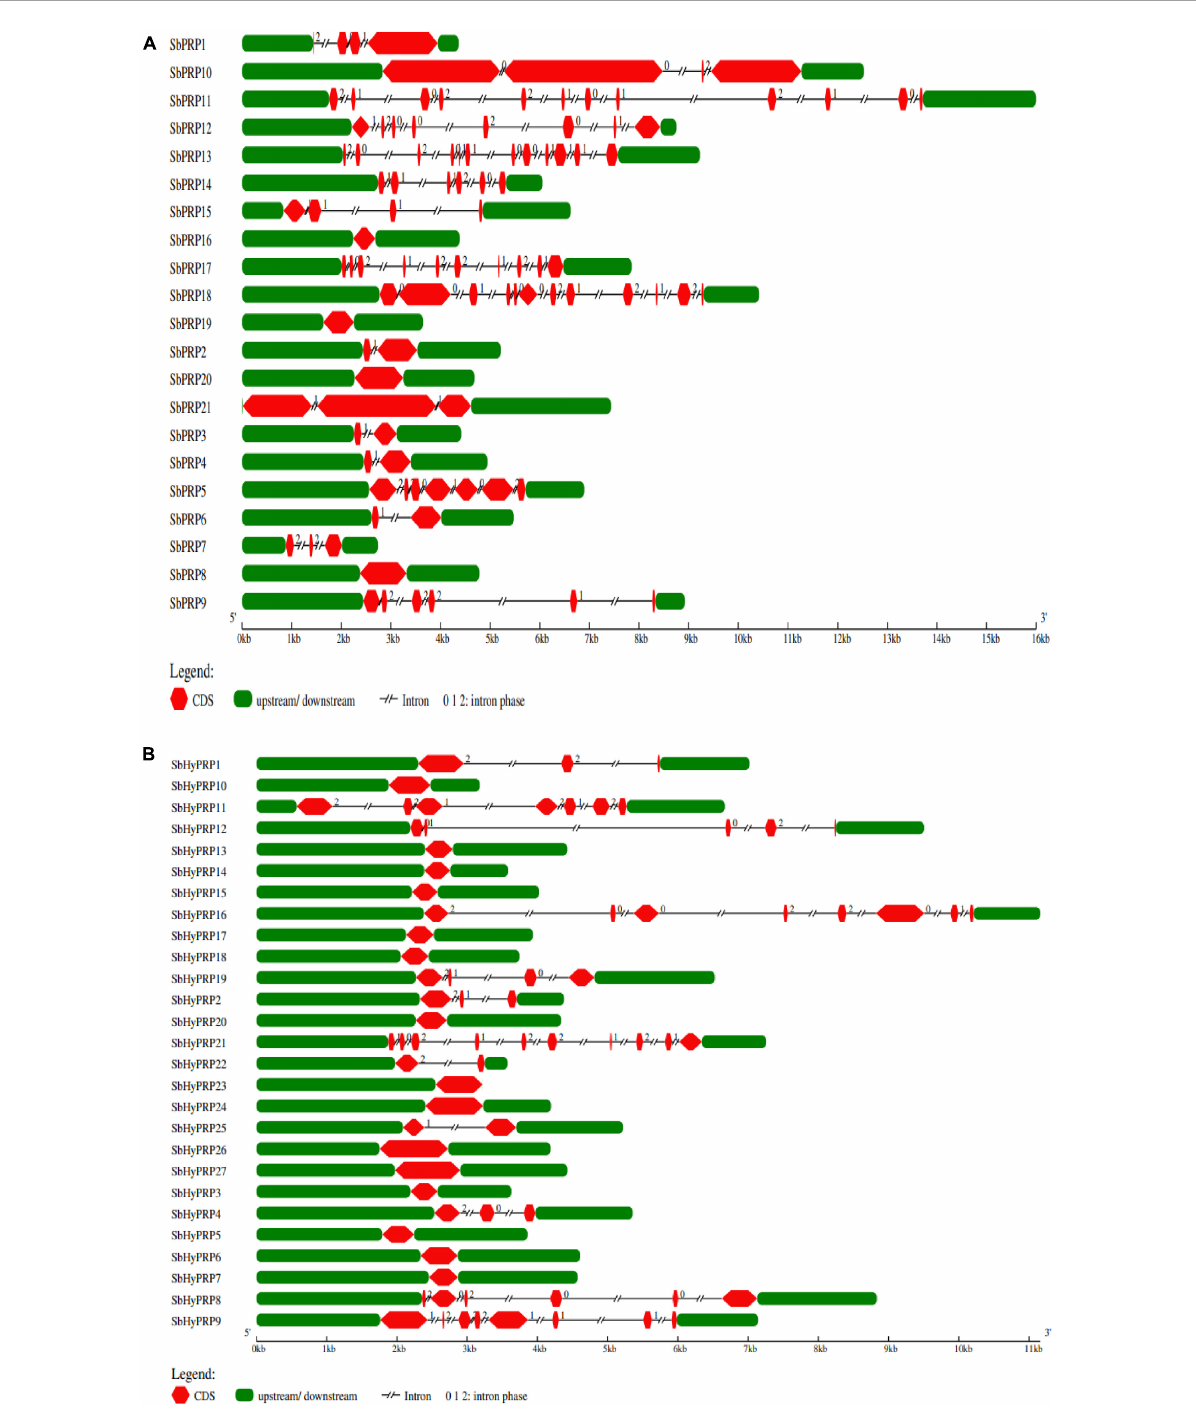
FIGURE3 Gene characterization of SbPRP and SbHyPRP genes. (A) Distribution of exons, introns, upstream, and downstream regions in SbPRPs , (B) distribution of exons, introns, upstream, and downstream regions in SbHyPRPs .